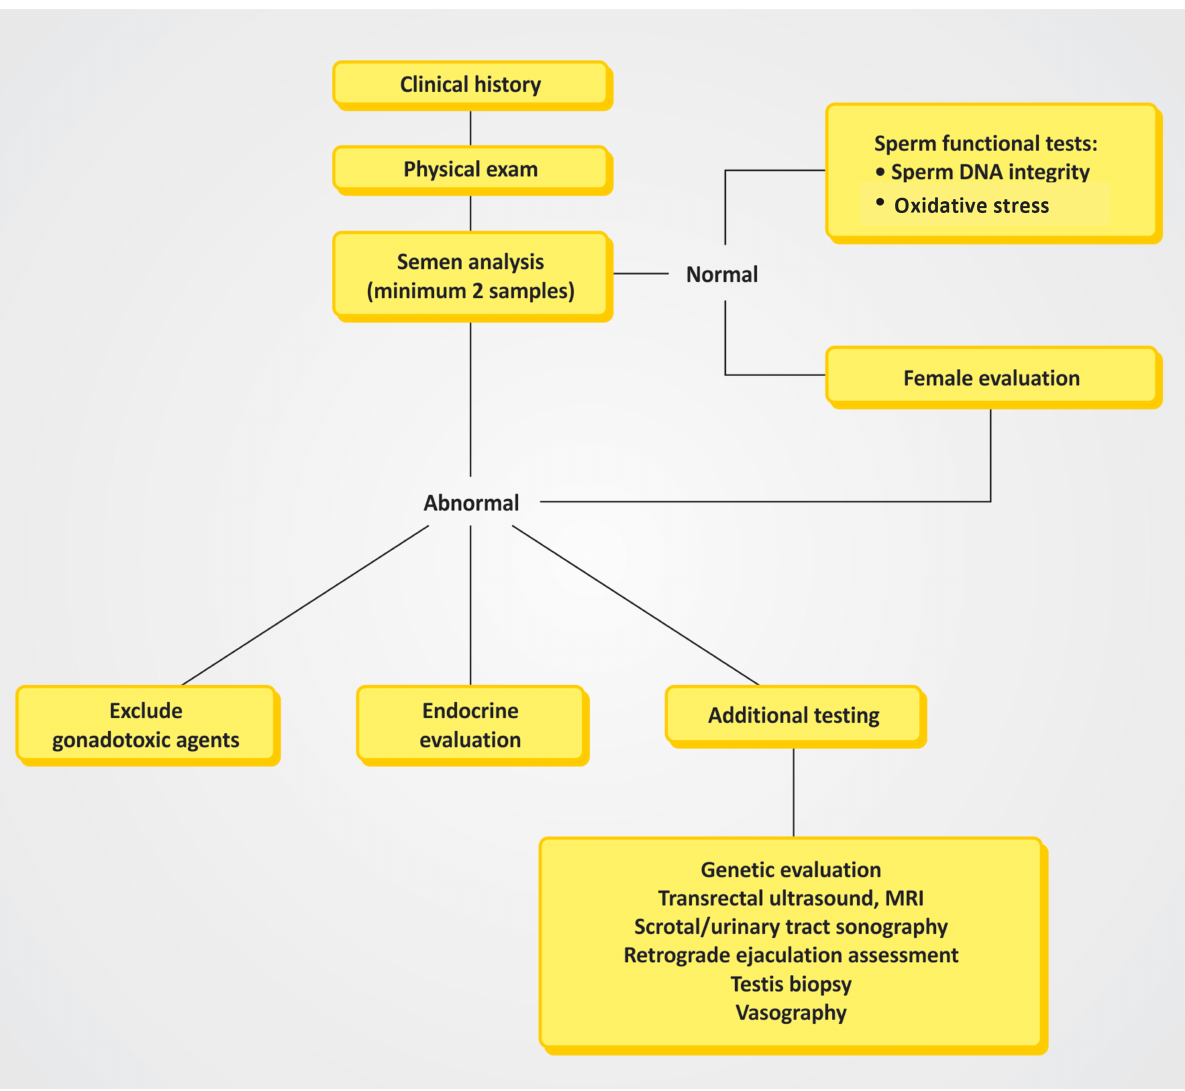
Figure 1. Simplified Algorithm for the Initial Male Infertility